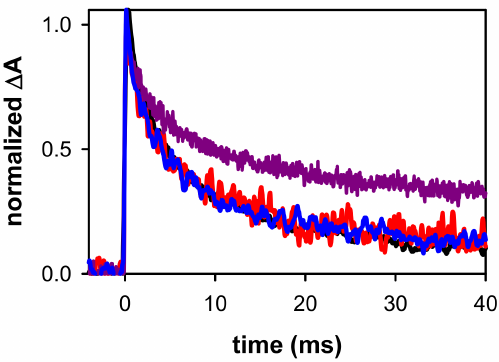
Figure 7. Normalized transient absorption decays determined for aerated solutions of (AG 4 A) 4 /K + at 385 nm (violet), 500 nm (blue) and 685 nm (red). For comparison, the decay obtained for (TG 4 T) 4 /K + at 605 nm [46] is shown in black.